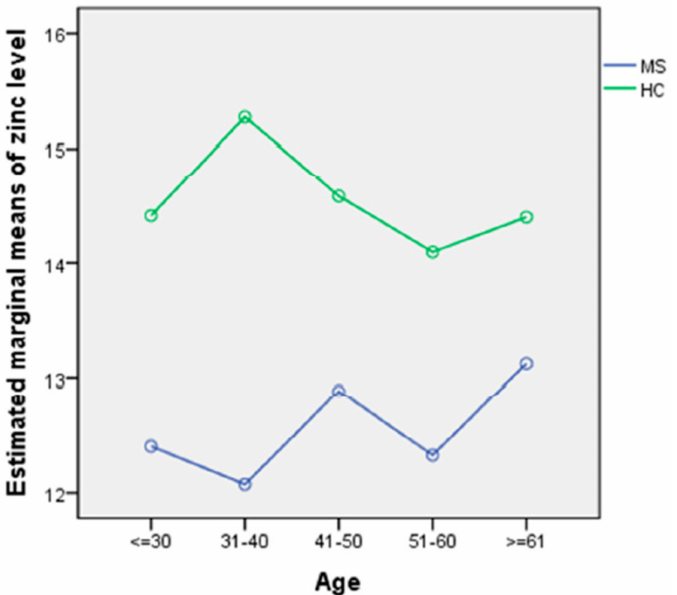
Figure 1. HCs = healthy controls, MS = multiple sclerosis. The profile plots show the estimated marginal means of zinc values separated for the two groups. There was no interaction between age and group. There was a main effect of group and no effect of age.